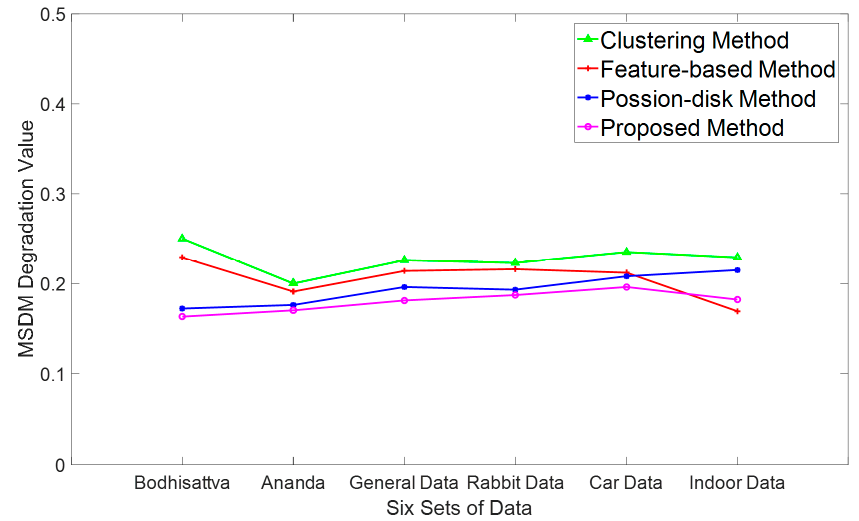
Figure 18. Perceptual degradations of four simplification methods.